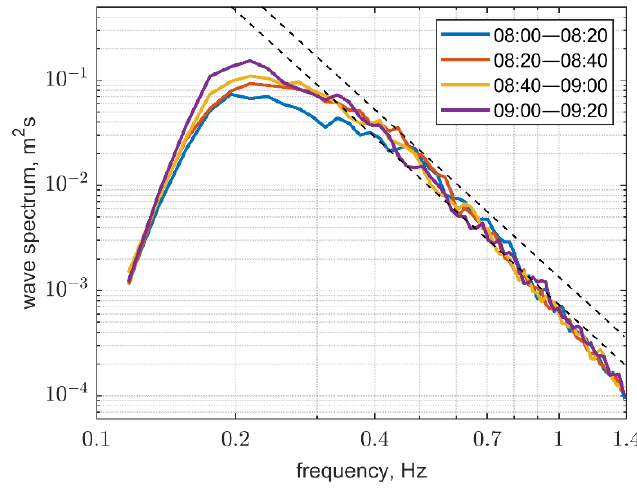
Figure 8. Frequency spectra of waves in the time intervals indicated in the legend. The dashed lines show the level of the “Toba spectrum” according to Equation (25).